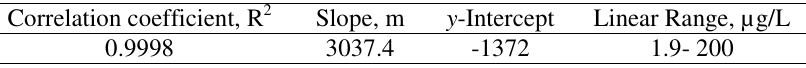
Table 4 . Regression data and statistical parameters for bromate